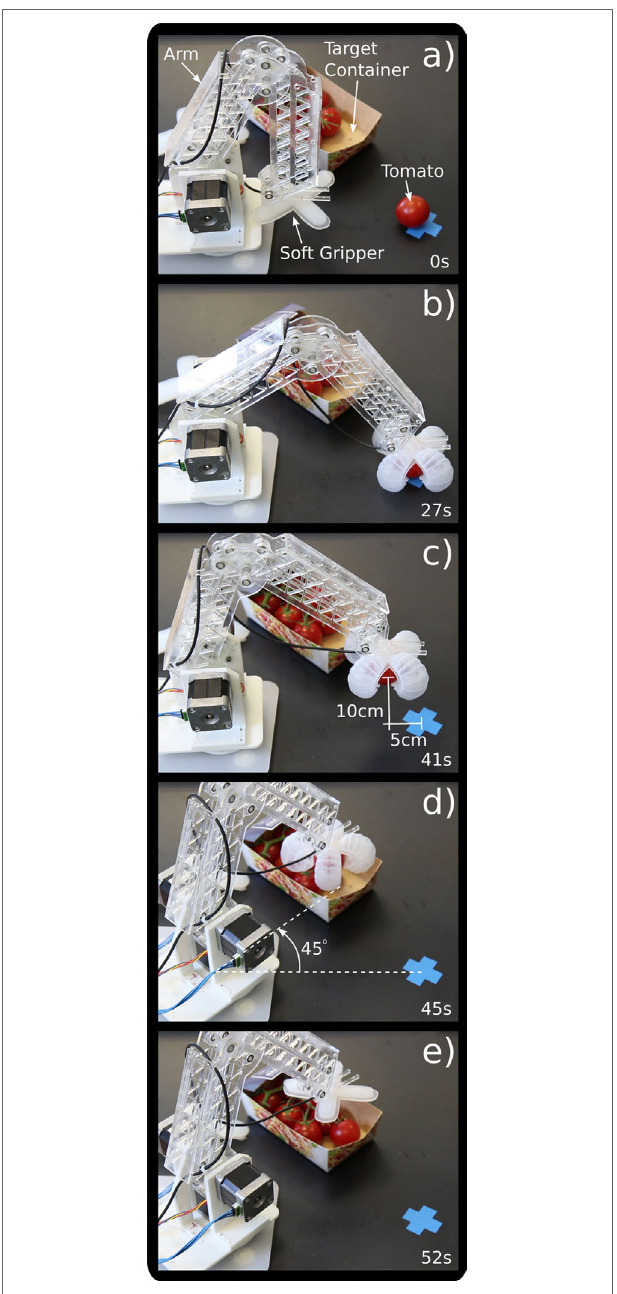
FigUre 3 | Still frames from a video of the arm performing a manipulation task with a tomato. In this task, a tomato is grasped, manipulated, and placed in a box. Frames at: (a) 0s, (B) 27s, (c) 41s, (D) 45s and (e)